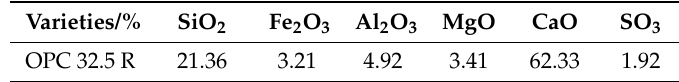
Table 2. Chemical composition of ordinary Portland cement OPC 32.5 R.